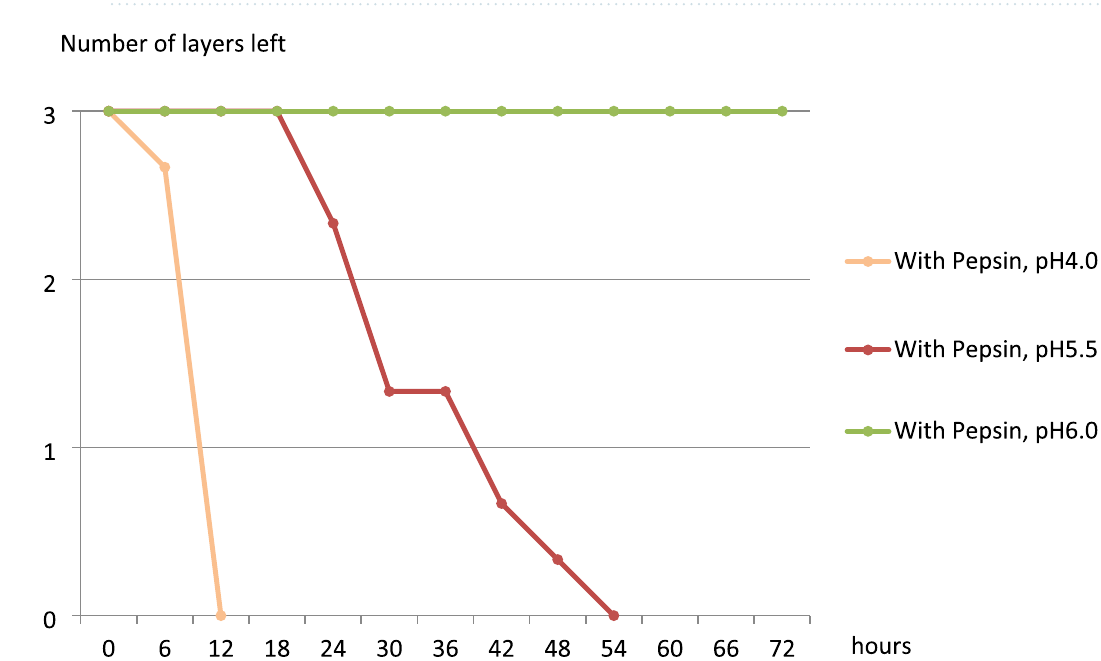
Figure 4. Change in the mean number of the remaining layers in the pH 1.2 and pH 2.0 with pepsin groups over time (N = 3).